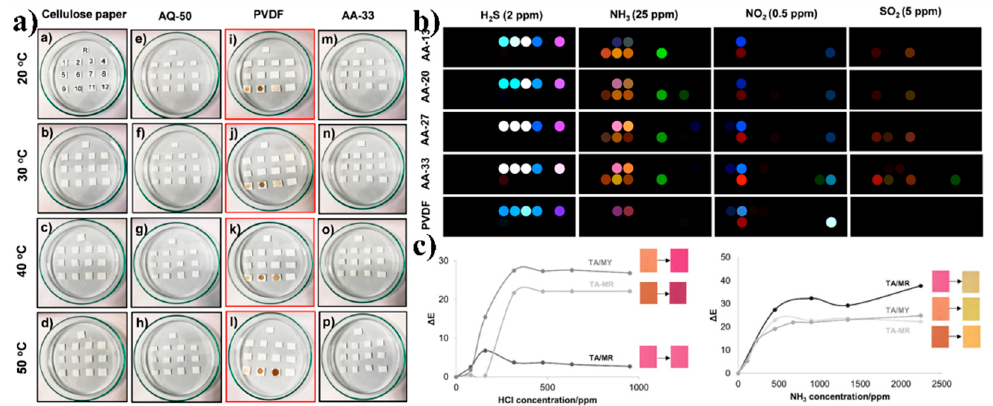
Figure 8. Electrospun NP interfaces for colorimetric sensor: ( a ) Digital photographs acquired in 12 h after chemical exposure at 20–50 °C for bare cellulose paper, AQ-50 substrate(The substrate prepared by this protocol was denoted as an AQ-50 substrate.), polyvinylidene difluoride (PVDF) membrane and AA-33 substrate; ( b ) color difference maps for AA-13 to AA-33 and PVDF-based colorimetric sensor array (CSAs), which include H 2 S, NH 3 , and NO 2 below their polyelectrolyte (PEL) concentrations and SO 2 at PEL concentrations [119], copyright 2018 Langmuir; ( c ) color difference between original sample and sample exposed to hydrogen chloride (HCl) (left) and NH 3 (right) [120], copyright 2016 Wiley-VCH.